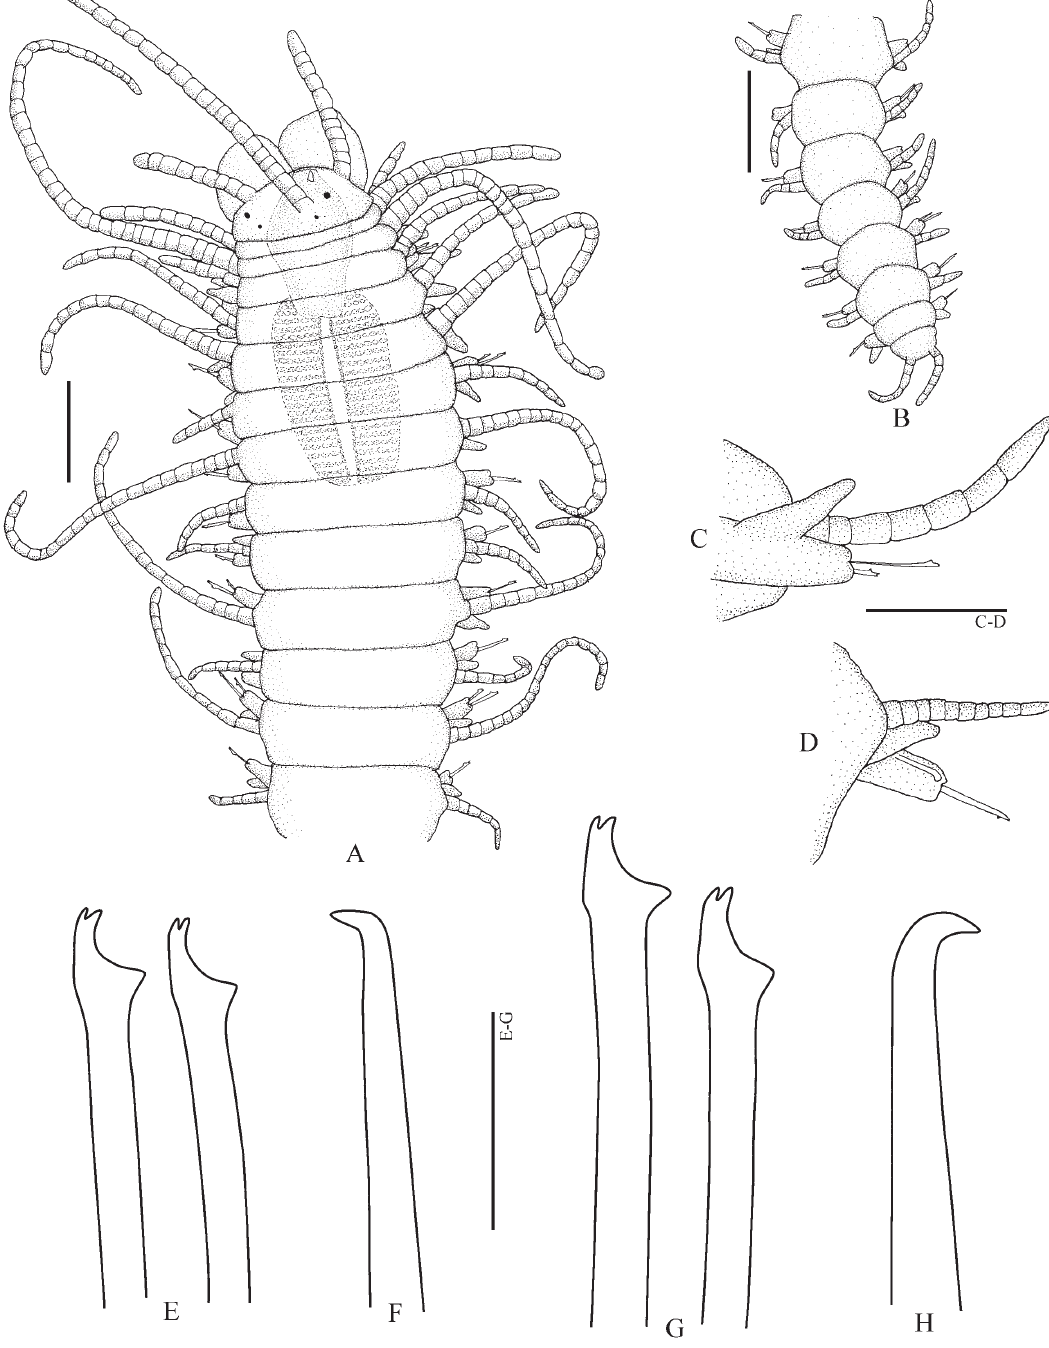
Fig . 11. – Hand-drawing of Haplosyllis gula . A, anterior end, dorsal view. B, posterior end, dorsal view. C, anterior parapodium, chaetiger 5. D, mid-body parapodium. E, anterior chaetae, chaetiger 3. F, anterior acicula, chaetiger 3. G, mid-body chaetae. H, mid-body acicula.